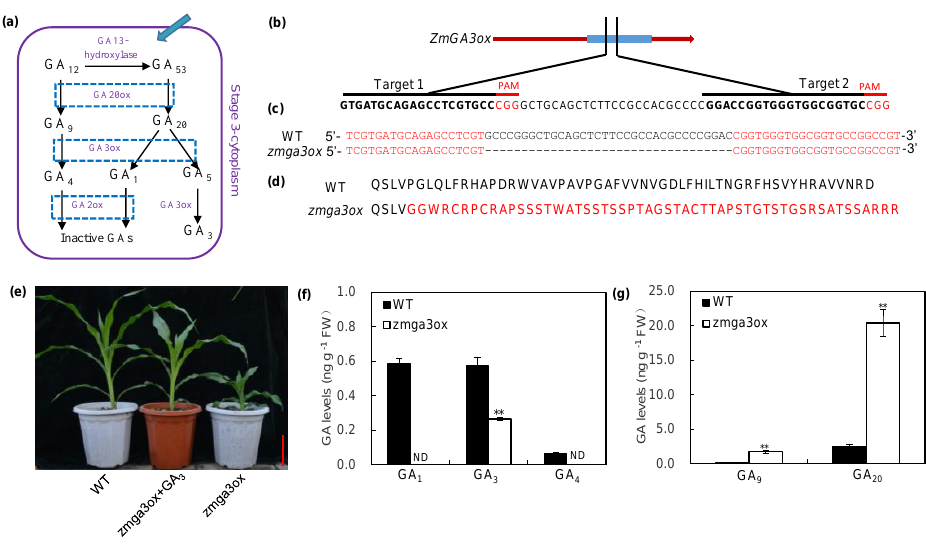
Figure 1. The ZmGA3ox knockout mutant characterization and phenotype analysis under sufficient nitrogen (SN) condition. ( a ) Schematic representations of the GAs biosynthesis pathway; ( b ) targeted mutagenesis of ZmGA3ox via CRISPR-Cas9; protospacer adjacent motif (PAM) sequences labelled in red; ( c ) sequence information of the gene-editing region in wild-type and zmga3ox plants; ( d ) alignment of the amino acid sequences of ZmGA3ox and zmga3ox. Only the sequences flanking the mutations were shown, and the frameshifted sequences in zmga3ox highlighted in red. ( e ) The phenotype of the zmga3ox and GA 3 -treated zmga3ox seedling. Bar = 20 cm. ( f ) The contents of GA 1 , GA 3 , and GA 4 in shoots of zmga3ox and wild-type seedlings. ND: not detected. ( g ) The contents of GA 9 and GA 20 in shoots of zmga3ox and wild-type seedlings. Values were the means ± SD ( n = 3). The asterisks indicated significant difference between wild-type and zmga3ox plants, as evaluated by Student’s t -tests ** p < 0.01.